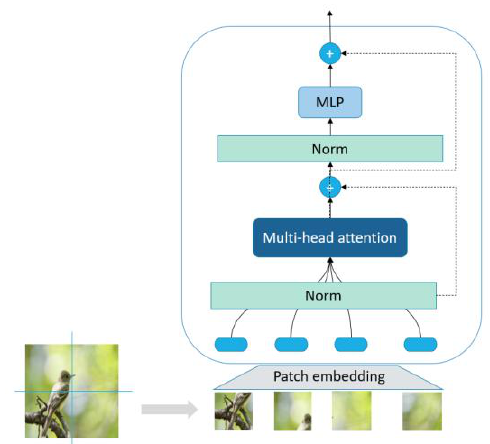
Figure 3. Transformer encoder: the module is combined with three key processes: normalization, multi-head attention, and non-linear mapping (MLP).